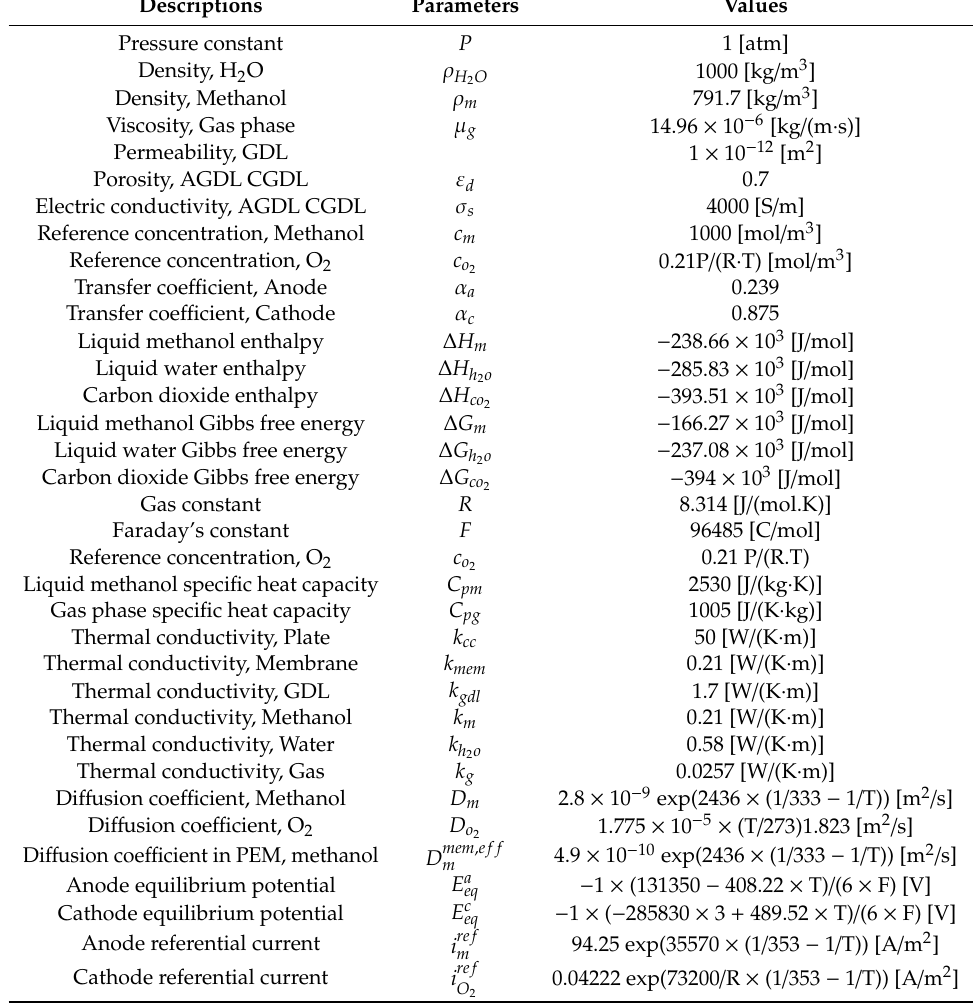
Table 1. Variables and parameters in the